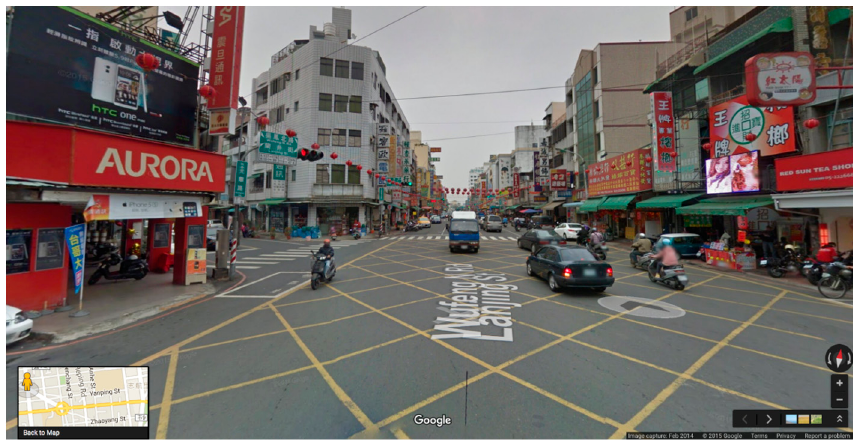
Figure 3. Example of a neighborhood in Chiayi City where the walkable environment is relatively poor. Source: Google Street View.